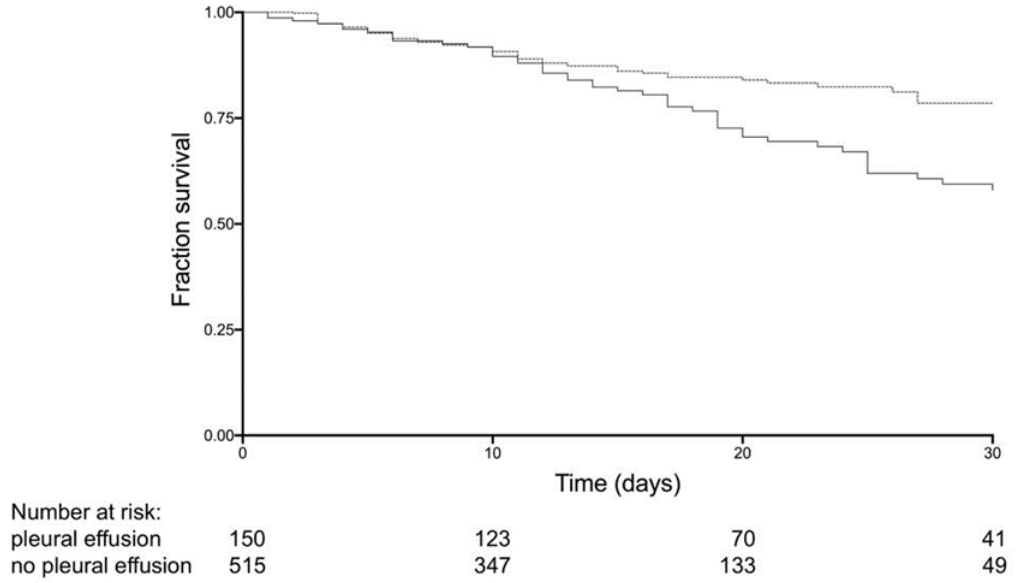
Figure 3. Level of care (HFNC: high-flow nasal cannula; CPAP: continuous positive airway pres- sure; NIV: non-invasive ventilation; ET: endotracheal intubation) for PE + and PE - patients. p < .001 by χ² test .